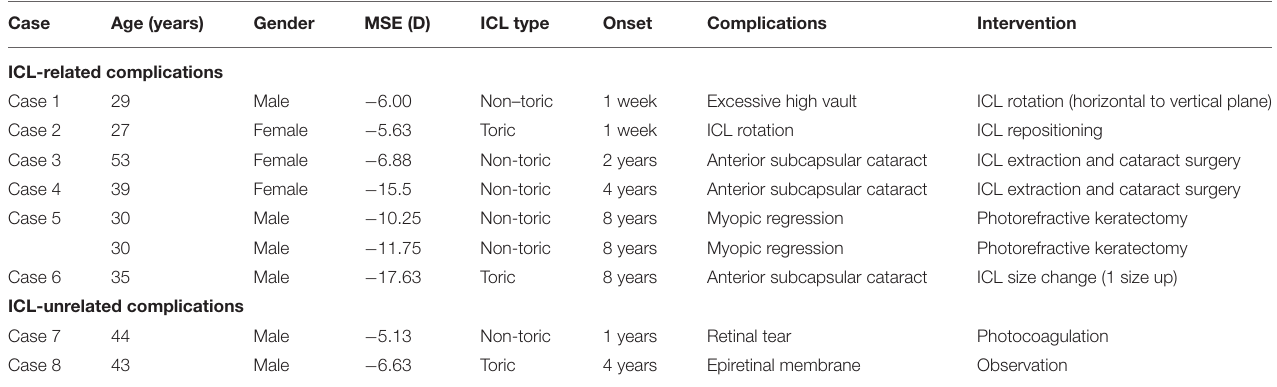
TABLE 2 | Postoperative complications and secondary surgical interventions after hole implantable collamer lens (EVO-ICL) implantation.